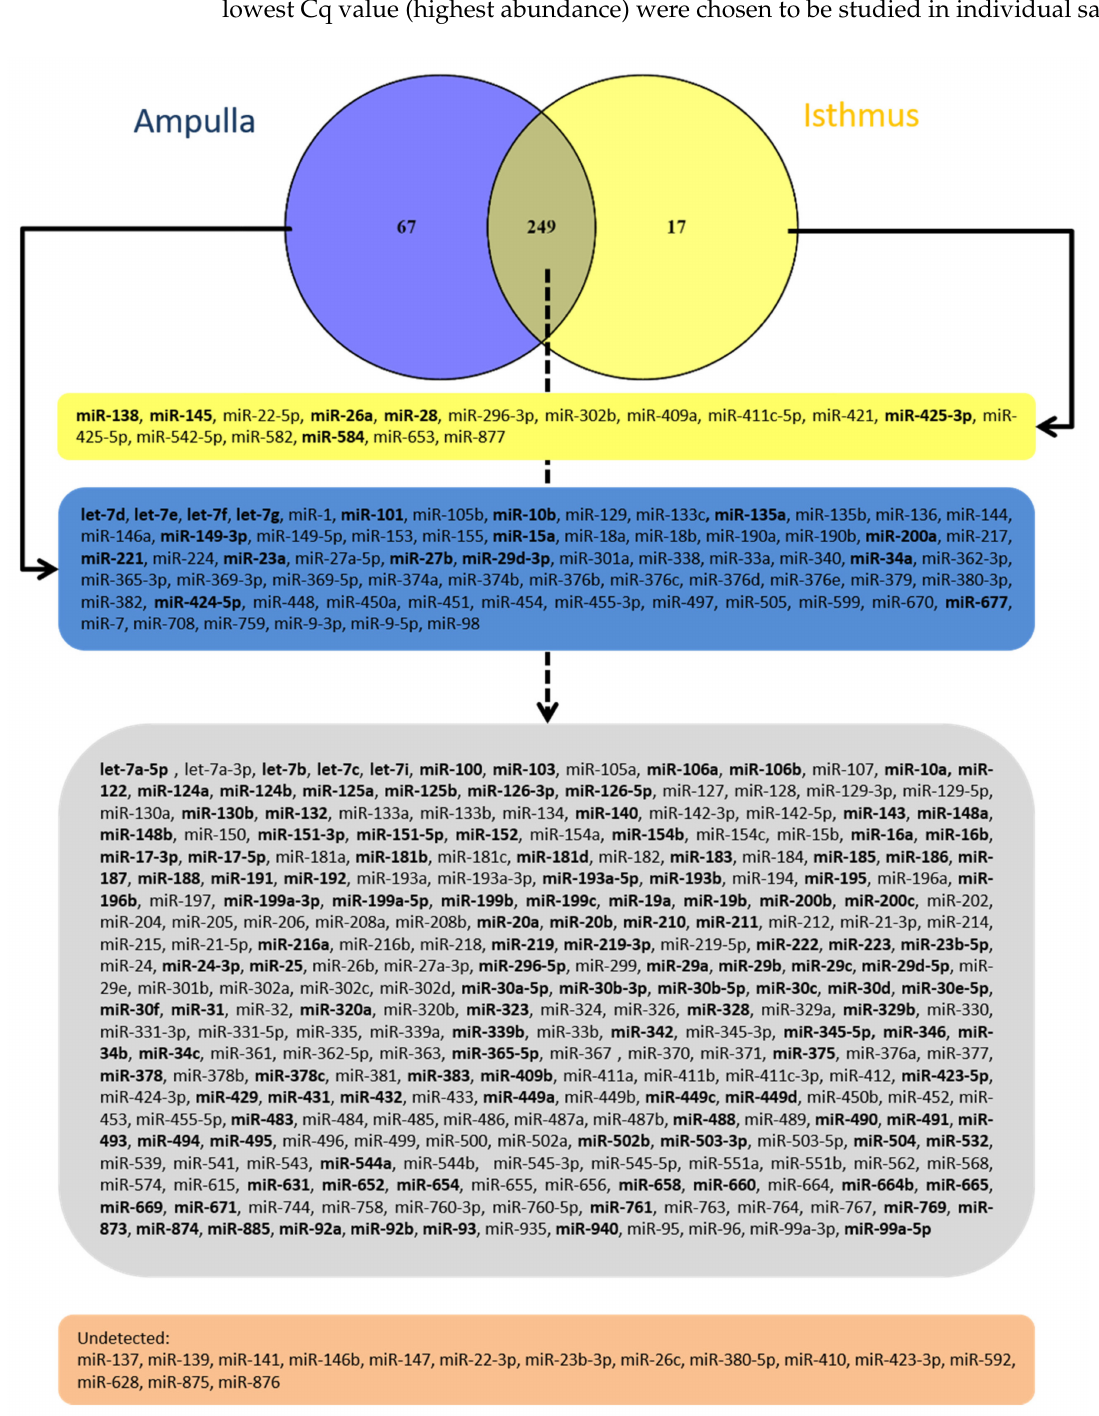
Figure 3. Venn diagram indicating the microRNAs detected in the ampulla and isthmus or undetected in both regions. miRNAs in bold font are those that were selected to be studied in phase